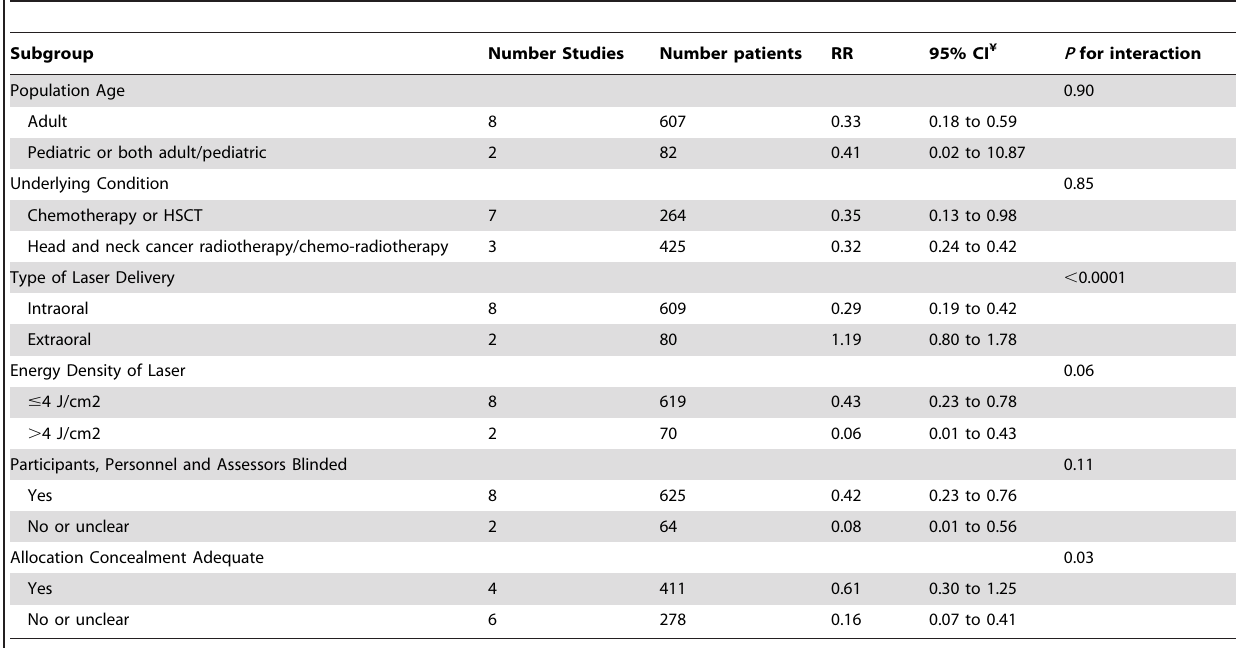
Table 3. Effect of low level laser therapy as compared to placebo/no therapy on overall incidence of severe (grade 3 or 4) mucositis stratified by patient, laser and risk of bias characteristics.